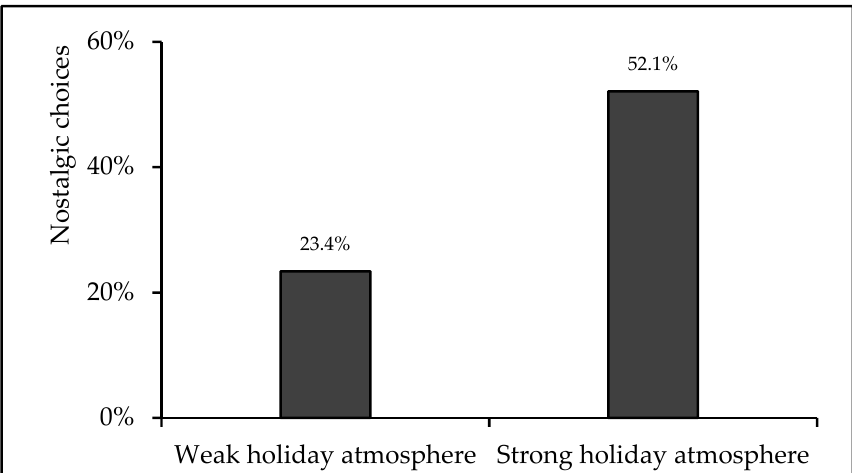
Figure 3. Choice of nostalgic products vs. non-nostalgic products. Childhood Imagery. A one-way ANOVA on childhood imagery was significant ( F (1, 93) = 35.53, p < 0.001), and planned contrasts revealed that the logo’s strong (vs. weak) atmosphere elicited more childhood imagery ( M strong = 5.26, M weak = 3.12). Mediation Analysis. To demonstrate that childhood imagery mediates the effect of logo’s holiday atmosphere on nostalgic preference, we performed a mediation analysis (PROCESS Model 4; [51]) with 5000 bootstrapping iterations. We coded holiday atmosphere (strong = 1, weak = 0) as the independent variable, nostalgic product choices as the dependent variable, childhood imagery as the mediator, and the interest, gender, age as covariates. Results revealed a significant indirect effect of holiday atmosphere on nostalgic product choices through childhood imagery (b = 0.47, SE = 0.37, 95% confidence interval [CI] = [0.027, 1.34]), see Figure 4. When childhood imagery was included in the model, the direct effect of holiday atmosphere on nostalgic product choices was not significant (b = 0.34, SE = 0.55, 95% confidence interval CI = [ − 0.73, 1.41]), indicating the effect of holiday atmosphere of logos on consumer nostalgic preference was fully mediated by consumers’ childhood